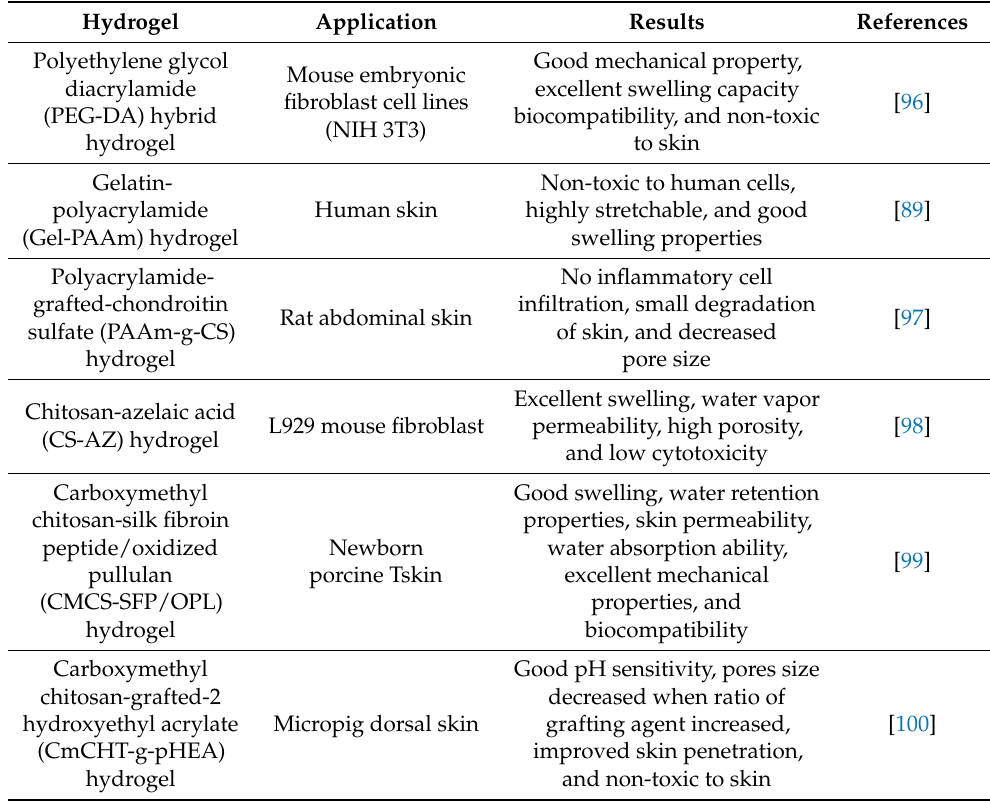
Table 1. The applications of hydrogel in transdermal drug